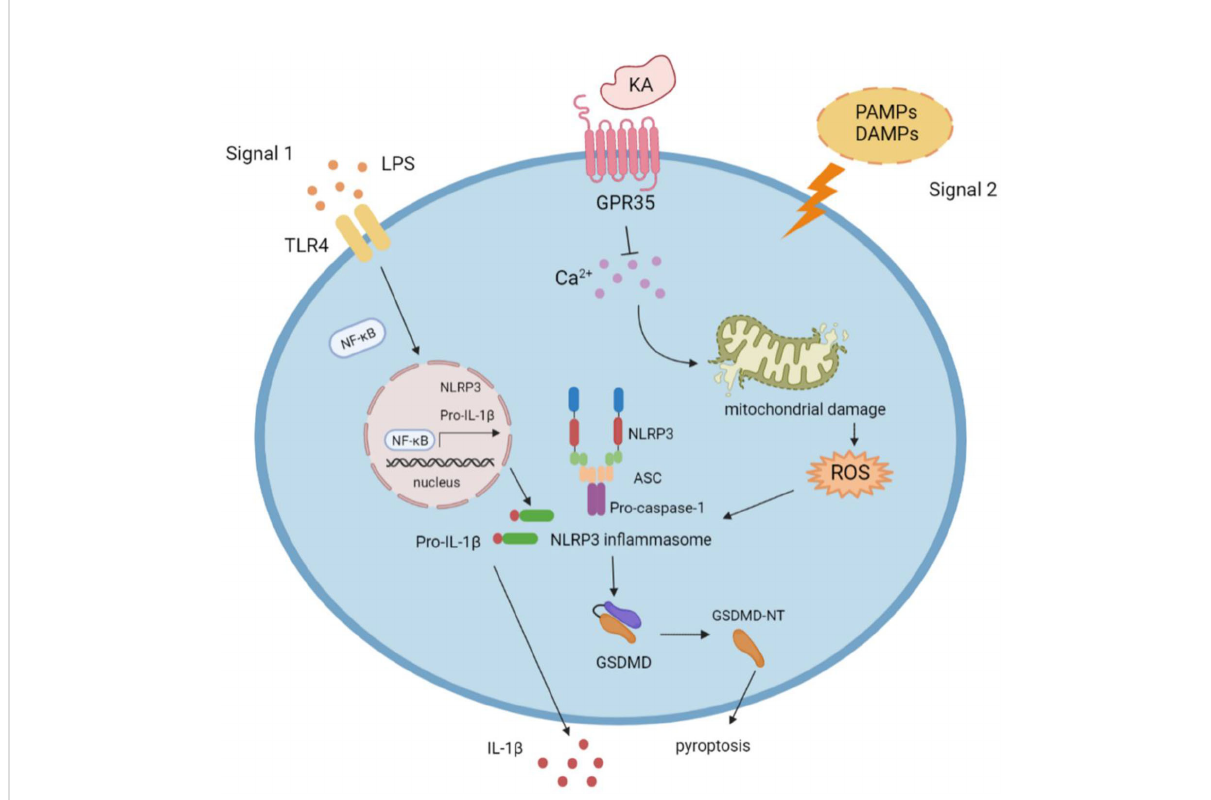
FIGURE 7 Model for KA-induced suppression of NLRP3 activation. Following the NLRP3 in fl ammasome priming step (signal 1), NLRP3-activating stimuli (signal 2) trigger NLRP3 in fl ammasome assembly and activation. KA suppresses NLRP3 in fl ammasome activation and NLRP3-associated diseases by suppressing calcium mobilization, reducing mitochondrial damage and mitochondrial ROS production, and blocking NLRP3 in fl ammasome assembly via